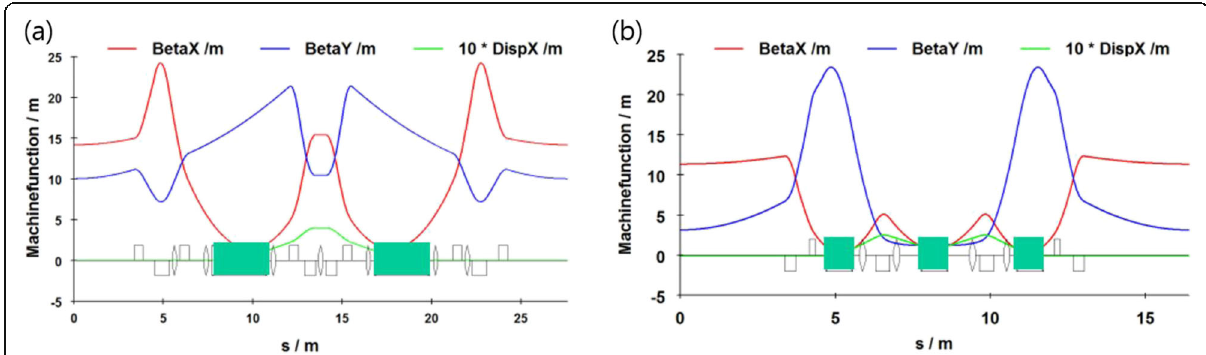
Fig. 2 Typical lattices for 3GSR [1]. a Double-bend achromat lattice. b Triple-bend achromat